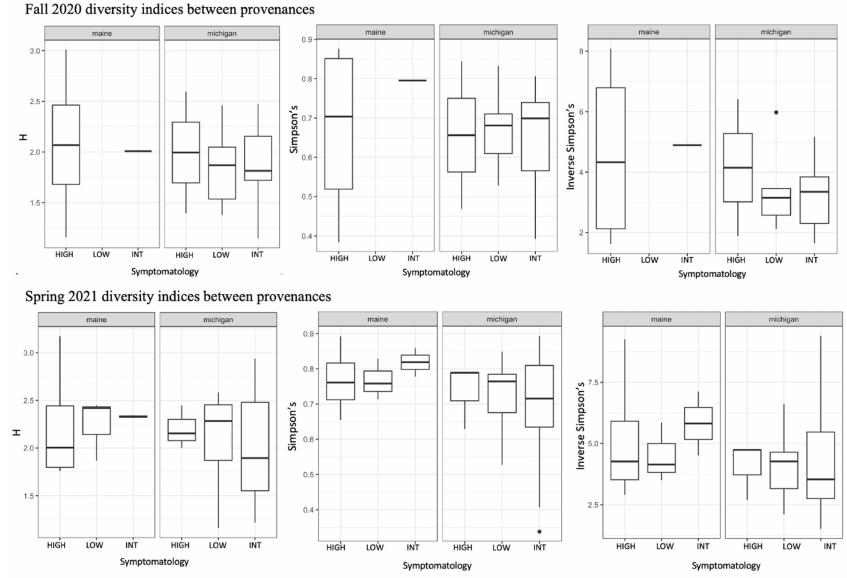
Figure 4. Results of diversity indices comparing root fungi from high, intermediate, and low symptom trees in each province for both collection periods. We analyzed Shannon diversity (H), Simpson’s